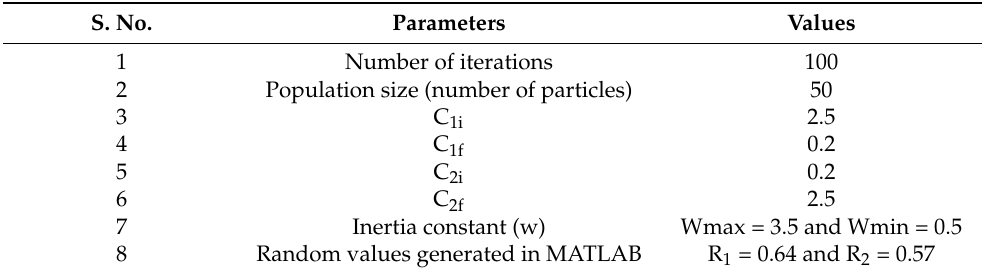
Table 3. Parameters used in convergence of novel PSO.